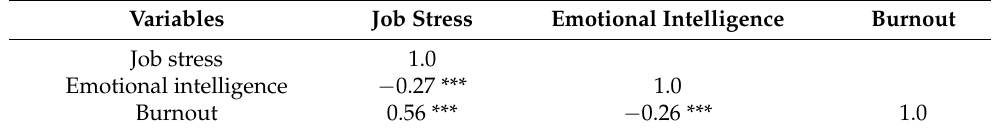
Table 3. Correlation matrix for job stress, emotional intelligence, and burnout. Variables Job Stress Emotional Intelligence